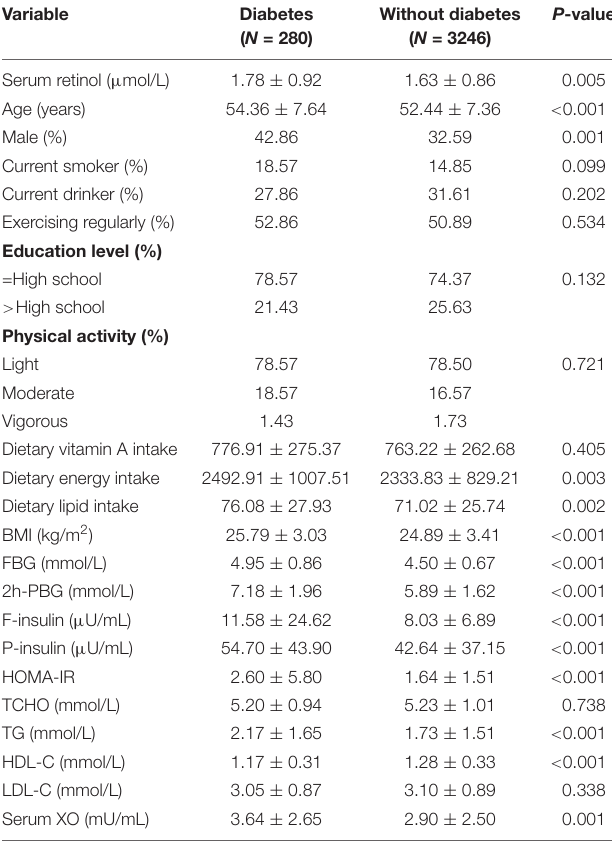
FIGURE 1 | The flowchart of the methodologies in this study.